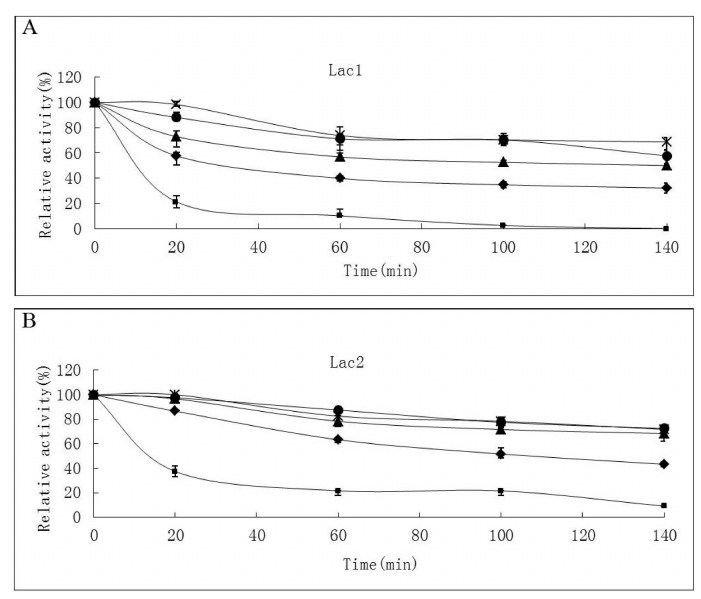
Figure 3. Effect of temperature on the activities of purified P. nebrodensis laccase isoforms. Measurements were carried out in triplicate (standard deviations for all data points <